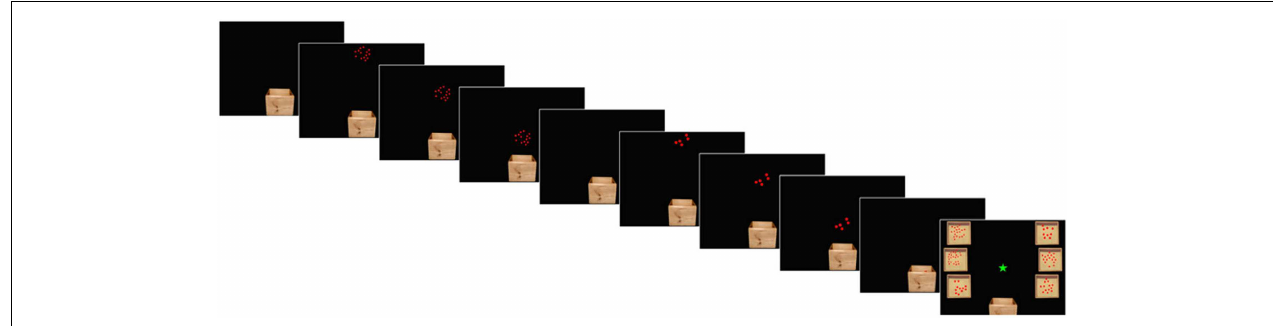
FIGURE 1 | Screenshots taken during an addition trial .Two dot clouds sequentially move from the top of the screen into the box before the inside of the box is shown with six response alternatives. Children were asked to indicate the correct outcome by clicking on the respective box.